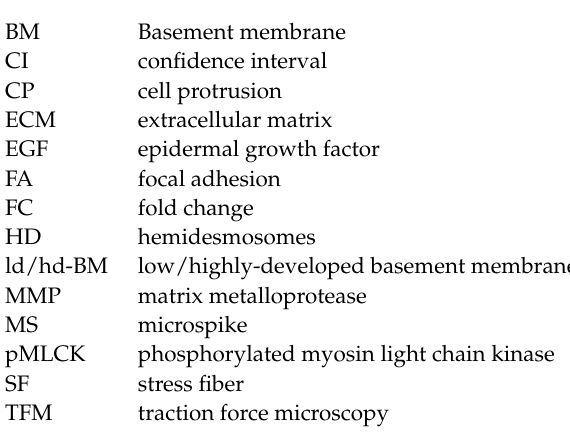
treatment, Figure S2: Invadopodia marker protein localization in single migrating cells and MCF10A acini, Figure S3: Focal adhesion and pMLCK localization in migrating MCF10-A cells, Figure S4: Traction force microscopy and hot spot segmentation, Movie S1: Lateral MS formation (Example 1), Movie S2: Lateral MS formation (Example 2), Movie S3: Lateral MS formation (Example 3), Movie S4: Migrating MCF10A cells, Movie S5: Movement of MCF10A acini on a tumor-like substrate (12